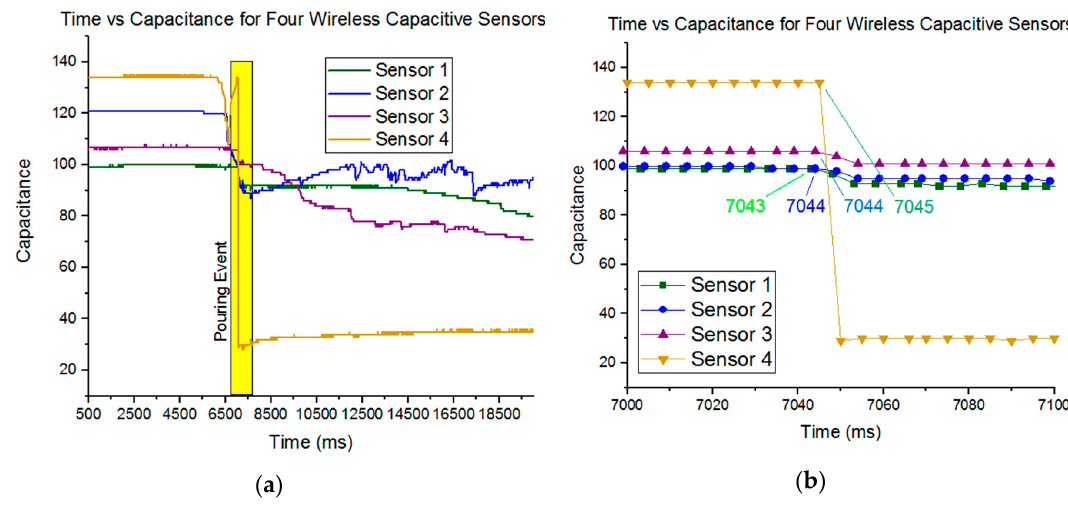
Figure A2. Wireless capacitive sensing for Nittany Lion paw casting using four capacitive sensors: ( a ) capacitance throughout the casting process, and ( b ) closer look at change in capacitance during mold filling.